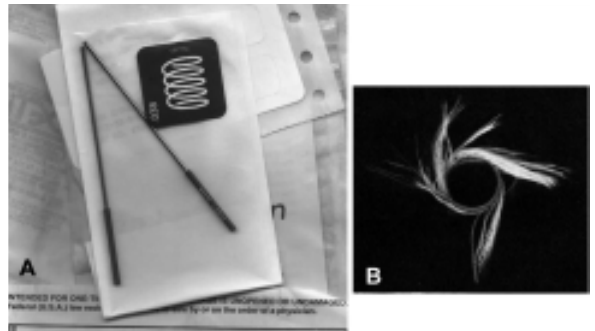
Fig. 4 - Commercial presentation of the Gianturco coils inside a metallic cartridge; the numbering system seen of the lower part of the illustration, identifies the characteristics of the coil; B) released coil showing the format of the loops and the defensive fringe of Dacron